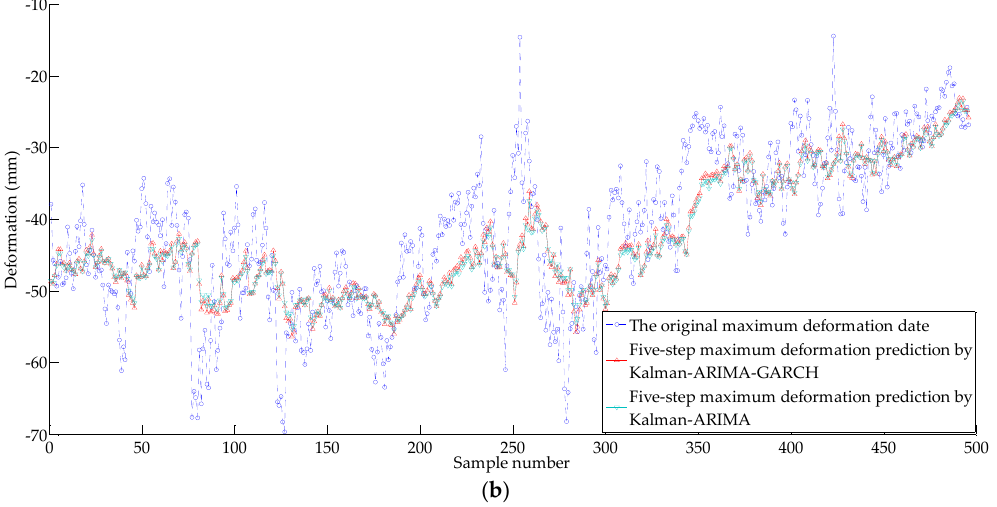
Figure 12. Results of the predictions for the original deformation series { X 2 t } by the ARIMA and the GARCH: ( a ) Five-step prediction; ( b ) Five-step maximum deformation prediction. Table 1. Analysis of the predictions given in Figure 11a.